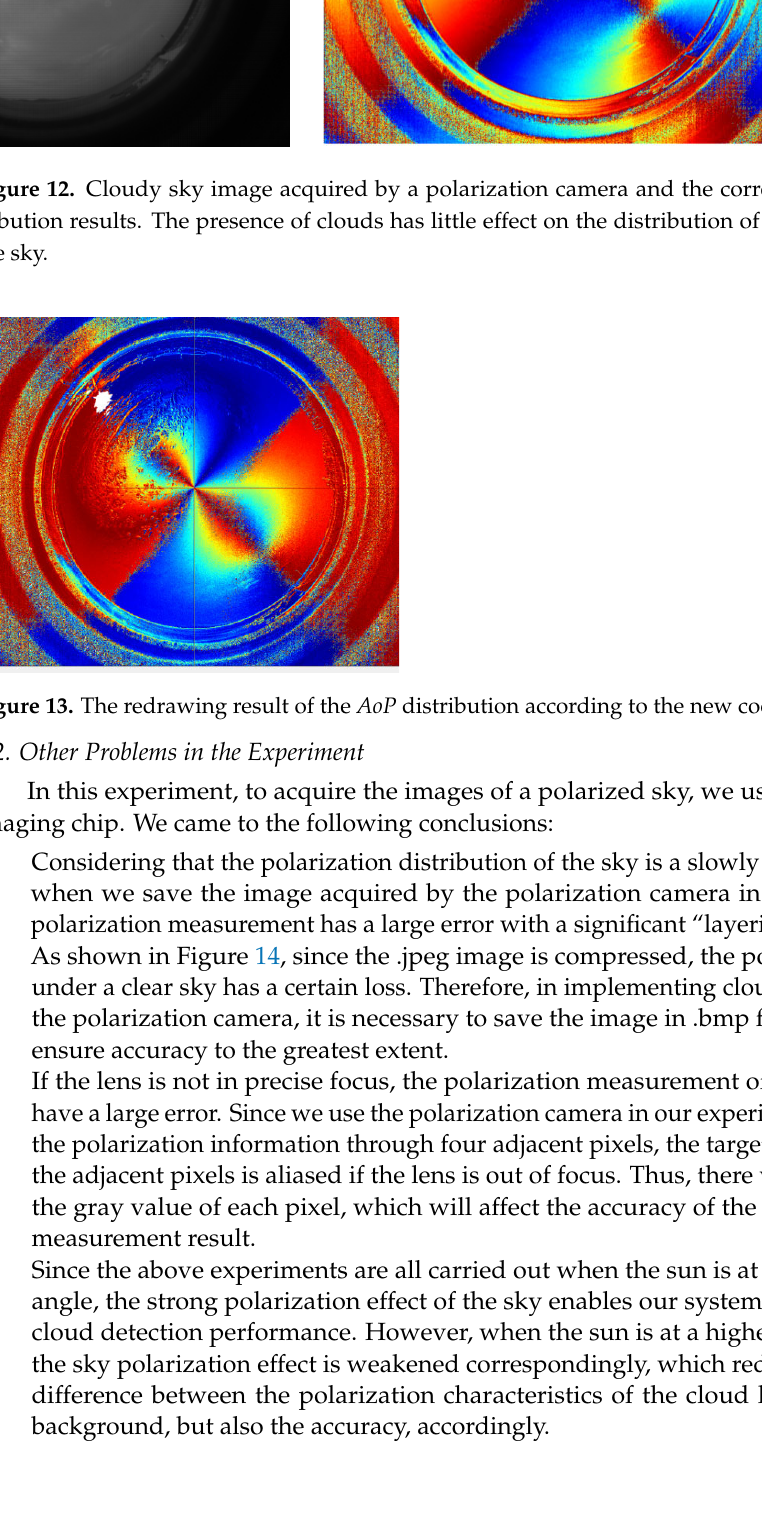
Figure 12. Cloudy sky image acquired by a polarization camera and the corresponding AoP distri ‐ bution results. The presence of clouds has little effect on the distribution of the original AoP in the sky.